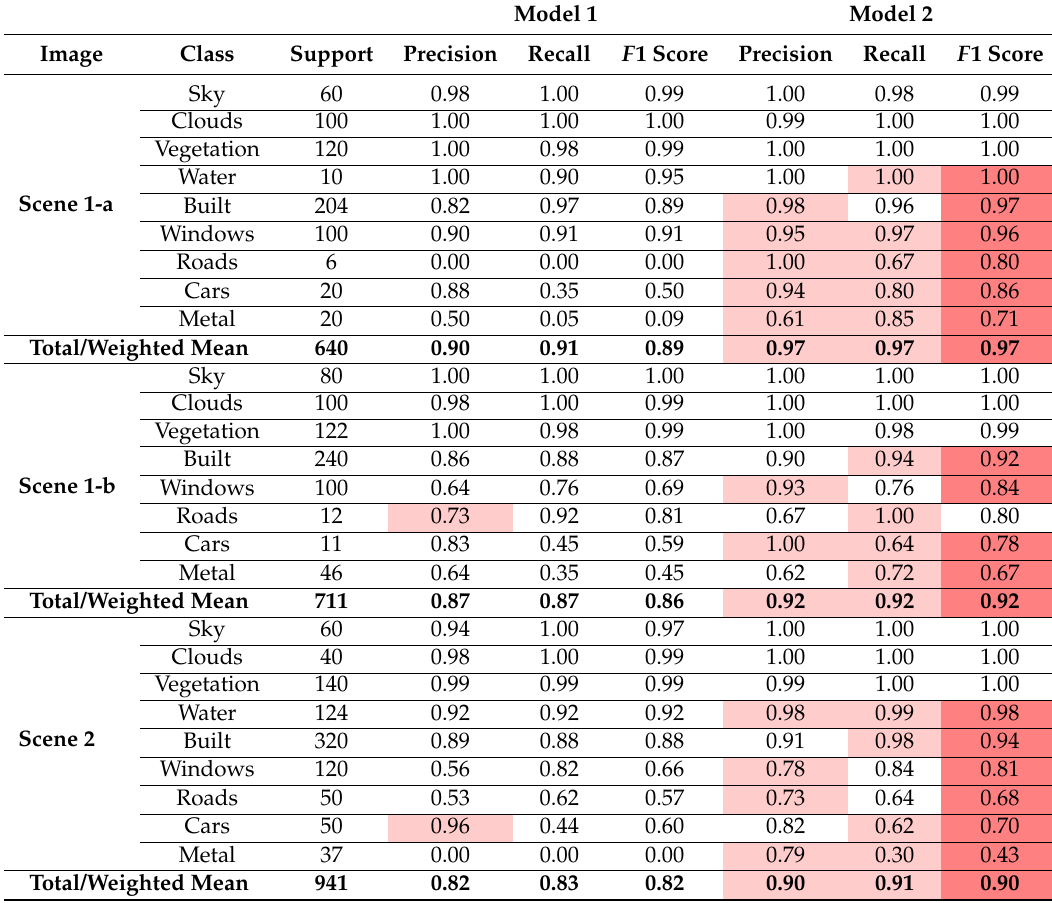
Table 1. Performance metrics for the classification of hand-labeled pixel spectra with Model 1 and Model 2 (see Figure 4) computed from the confusion matrices provided in Appendix A Figure A1. Each model was trained and tested separately for each scene using only its own hand-labeled spectra. Comparisons between Model 1 and 2 are indicated with highlighted cells: dark highlighting indicates greater F 1 score by at least 5% and light highlighting indicates greater precision or recall by at least